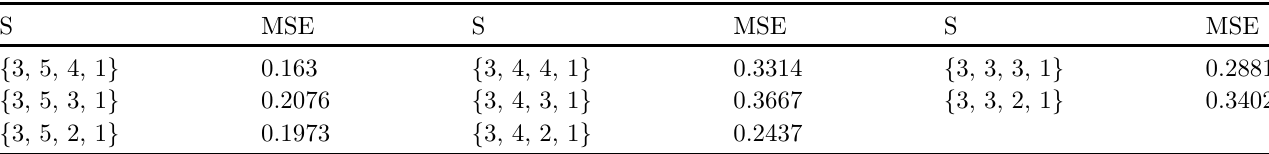
Table 10. ANN Algorithm: RPROP+.